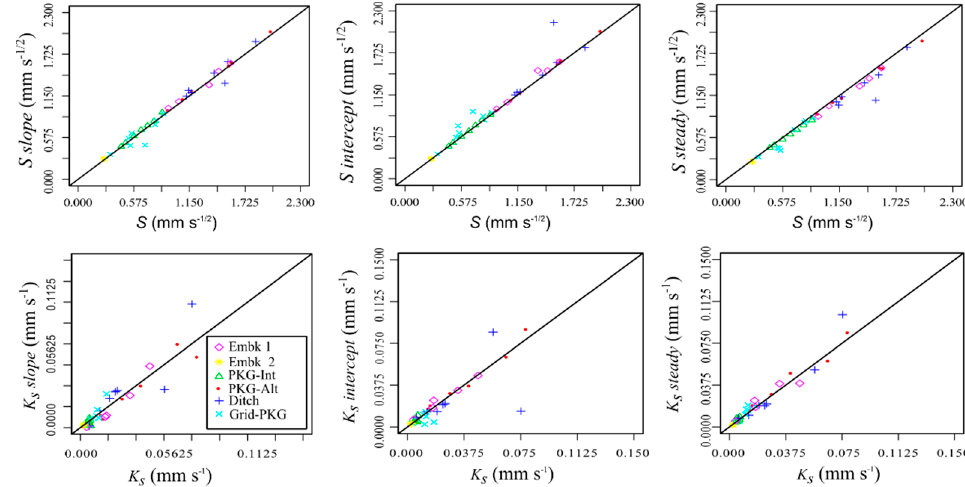
Figure 8. Parameters K s and S vs. their mean values by the three BEST methods.